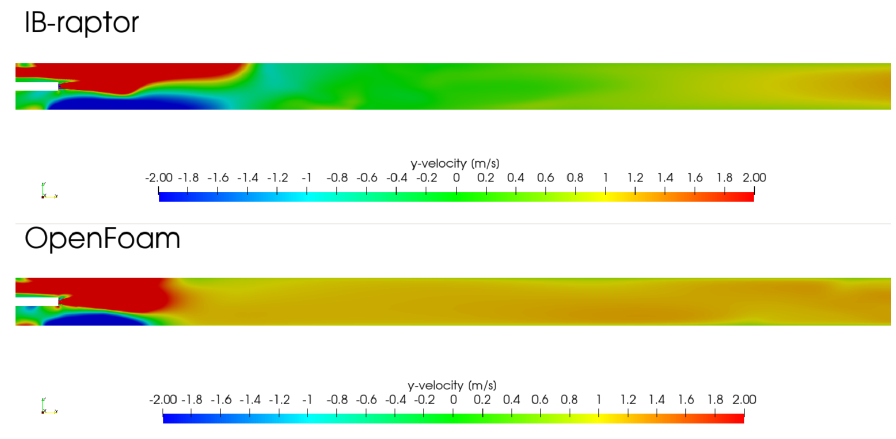
Figure 3. Clipped axial velocity in m/s computed by: IB-Raptor ( top ); and rhoSimpleFoam ( bottom ).